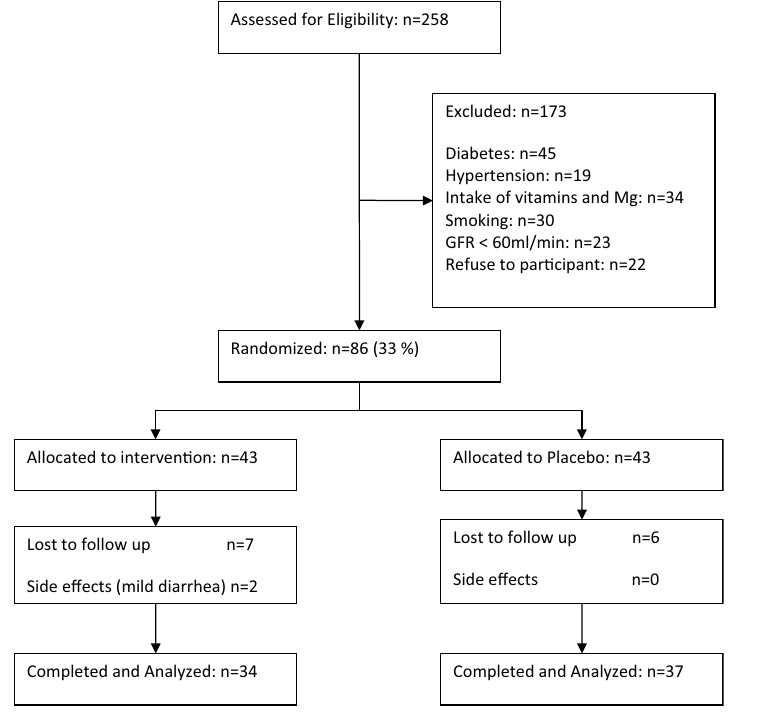
Figure 1. Flow diagram of